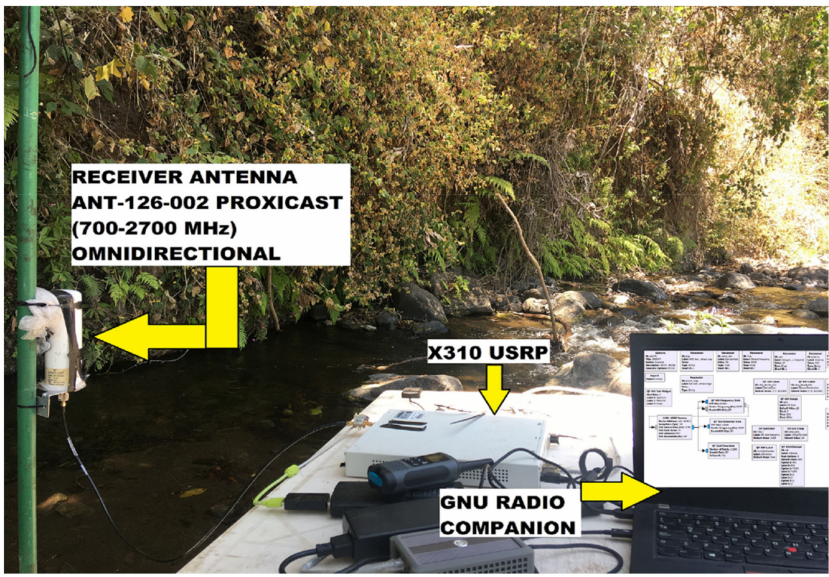
Figure 8. This image shows the devices used in the receiver node: the X310 radio, passband filter, a laptop with GNU Radio, and its corresponding antenna. The surrounding environment is composed of rocks, freshwater, and